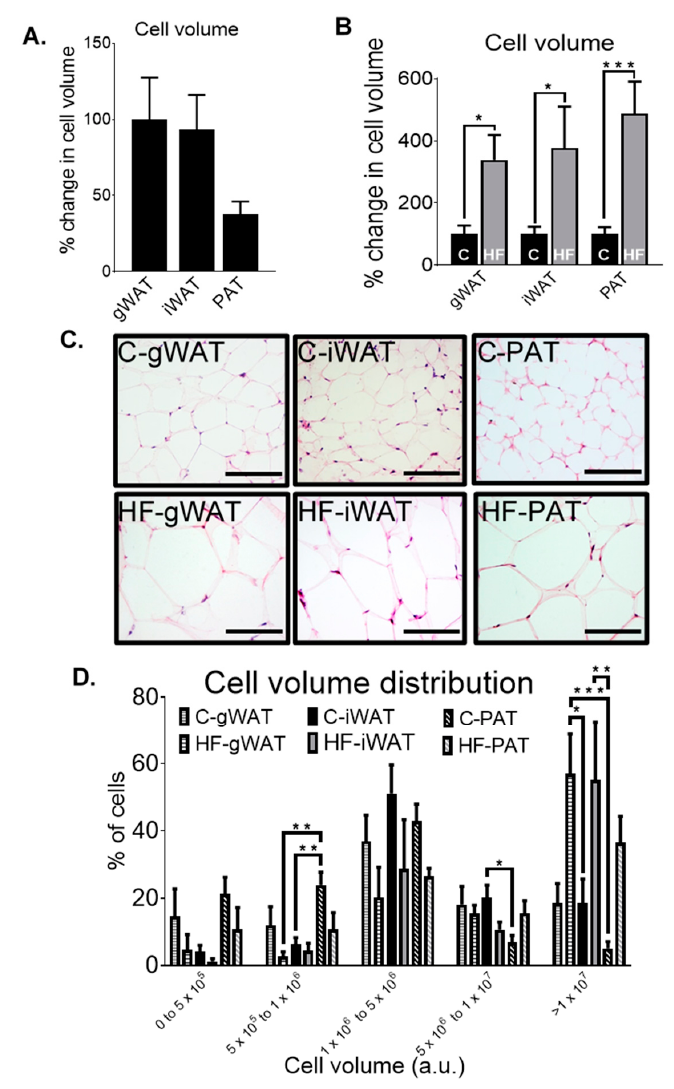
Figure 7. Percentage change in adipocyte volume (a.u.) of gWAT, iWAT and PAT from 30-week-old chow ( C )-fed mice. Data normalised to C-gWAT. Data were analysed by one-way ANOVA and Tukey’s multiple comparison test. N = 8–11 ( A ). Percentage change in adipocyte volume of chow (C)- or high-fat (HF)-fed 30-week-old mice from gWAT, iWAT and PAT. Data normalised to their respective control ( C ) within each depot. Data were analysed by an unpaired t-test between C and HF of each depot. N = 6–11 (B). Representative H&E stained images of chow (C)- or high-fat (HF)-fed 30-week-old mice from gWAT, iWAT and PAT. All scale bars 100µM. N = 6–11 ( C ). Distribution of adipocyte volume of chow (C)- or high-fat (HF)-fed 30-week-old mice from gWAT, iWAT and PAT. Data were analysed by one-way ANOVA and Tukey’s multiple comparison test between gWAT, iWAT and PAT of each cell volume (a.u.) bin. N = 6–11 (D). All data represent mean + s.e.m ( A , B , D ). * p < 0.05, ** p < 0.01 and *** p < 0.001 ( A , B , D